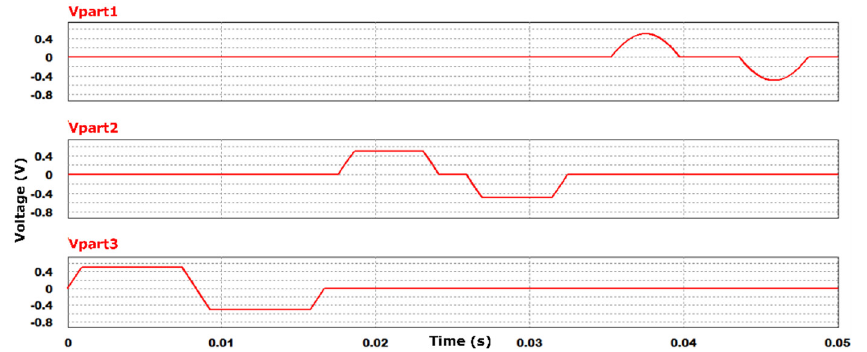
Figure 8. Chopped sinewave signal.